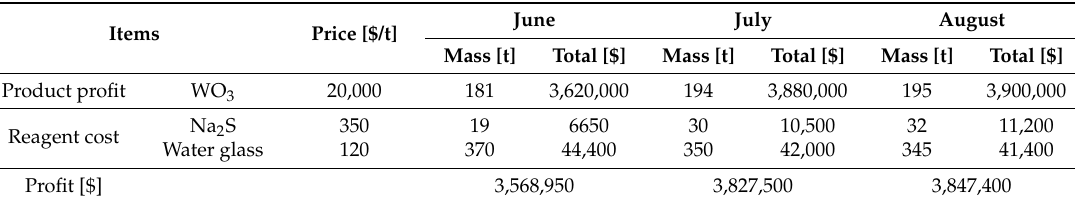
Figure 5. Monthly details of scheelite heating flotation using the old (June) and new (July and August) reagent regimes. Table 1. Economic evaluation results of scheelite heating flotation using the old (June) and new (July and August) reagent